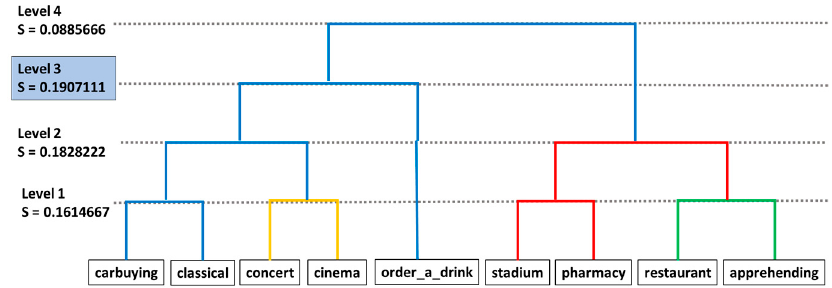
Figure 2. Hierarchical clustering algorithm and cut-off point.